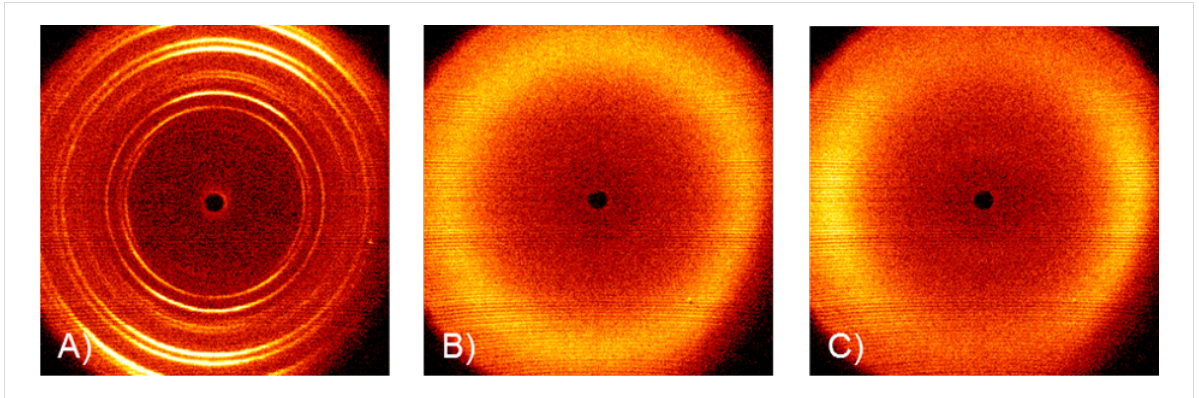
Figure 5: 2D X-ray scattering patterns of 11a : (A) crystalline phase at 50 °C, (B) isotropic phase at 25 °C, and (C) nematic phase at 15 °C.